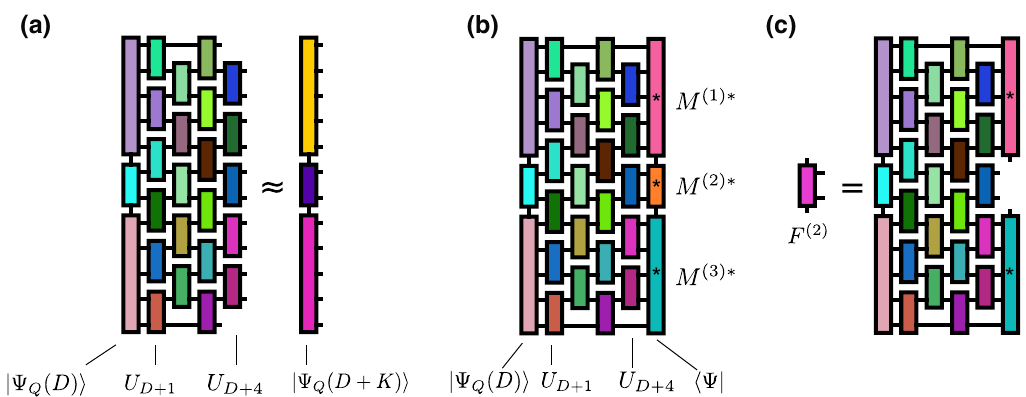
FIG. 4. Compression step in the DMRG algorithm. (a) General schematic of the compression step: one adds K layers of the quantum circuit, then approximates the resulting state with a MPS. (b) Tensor network representation of the scalar product to be optimized [Eq. (18)]. The asterisk indicates the use of the complex conjugate of the tensor. (c) The central part of the calculation is the computation of the F (τ)